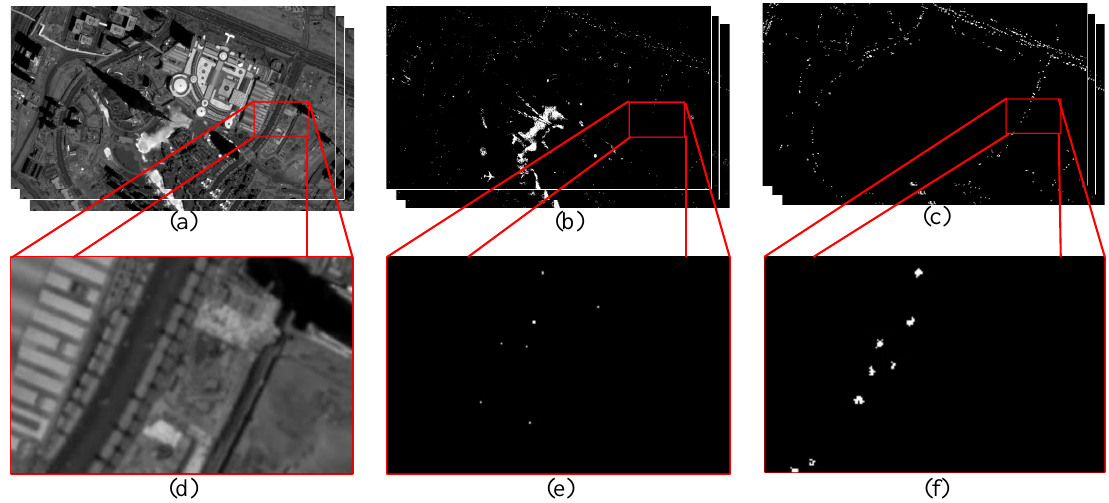
Figure 7. ( a ): the original image; ( b ): the detection result of ViBe (Visual Background extractor); ( c ): the detection result of our method; ( d ): partially enlarged image of the original image; ( e ): the partially enlarged image of ( b ); and ( f ): the partially enlarged image of ( c